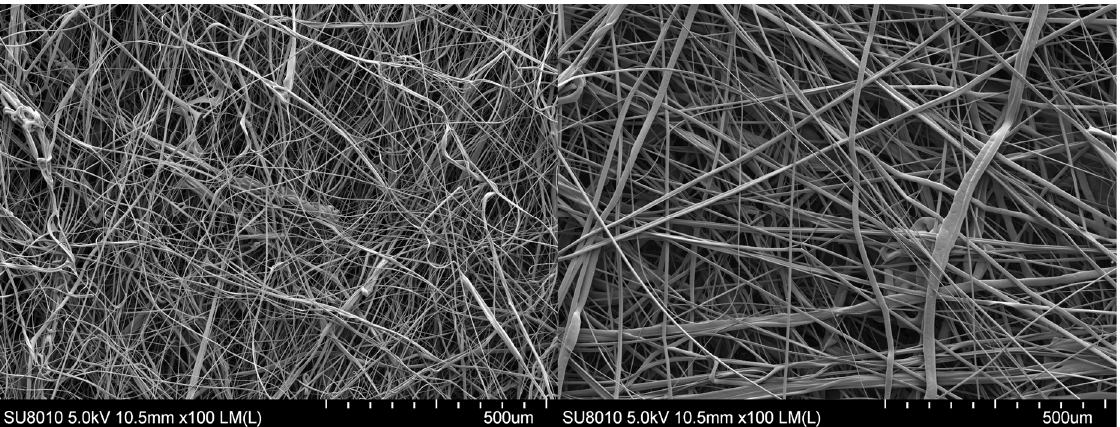
Figure 4. Structure of the ( left ) F1 filter and ( right ) F6 filter.